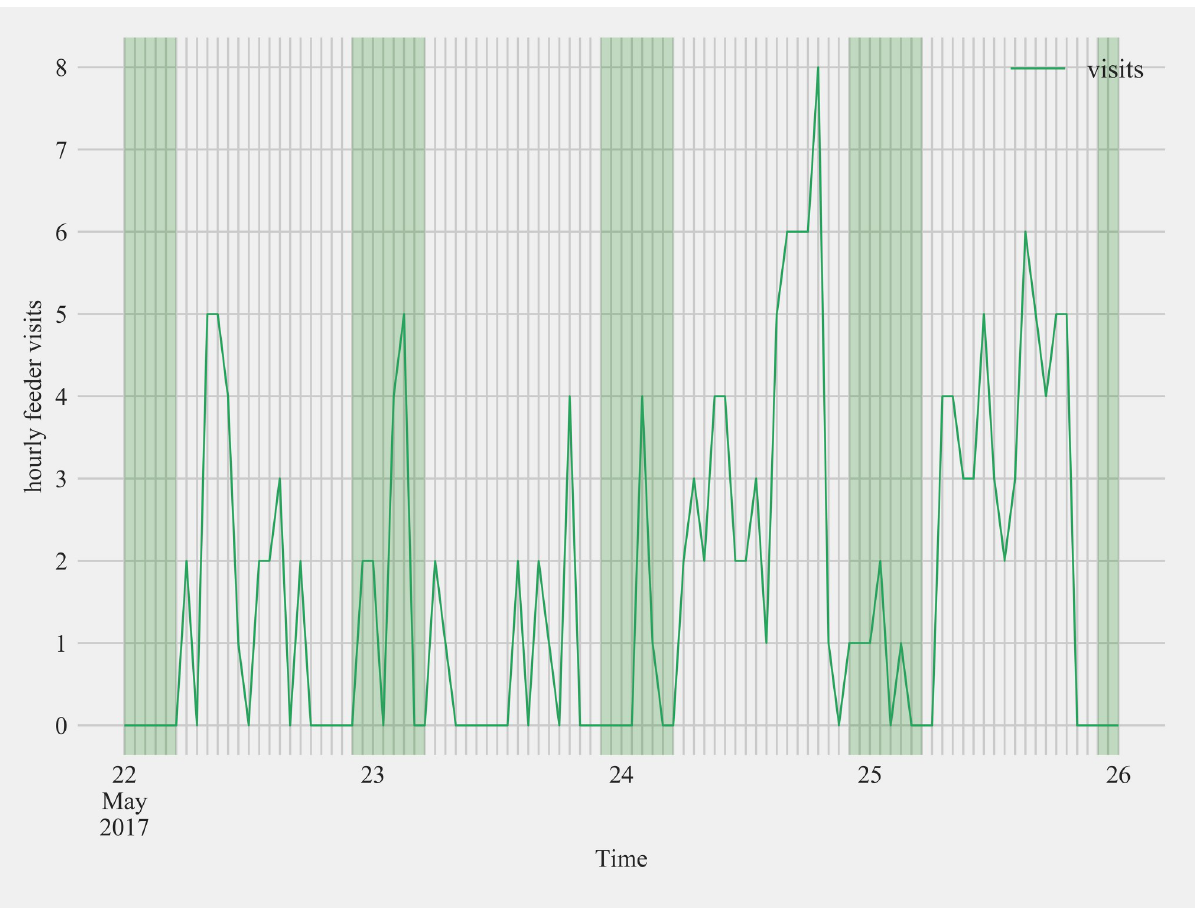
Fig 9. Feeder visit activity of an after-hatch year male Anna’s hummingbird with a subcutaneously placed passive integrated transponder at Site 2 between May 22nd and May 26th 2017. This bird was detected at the feeder after sunset, evident in the peaks of hourly visits during the night (green shaded sections of plot).